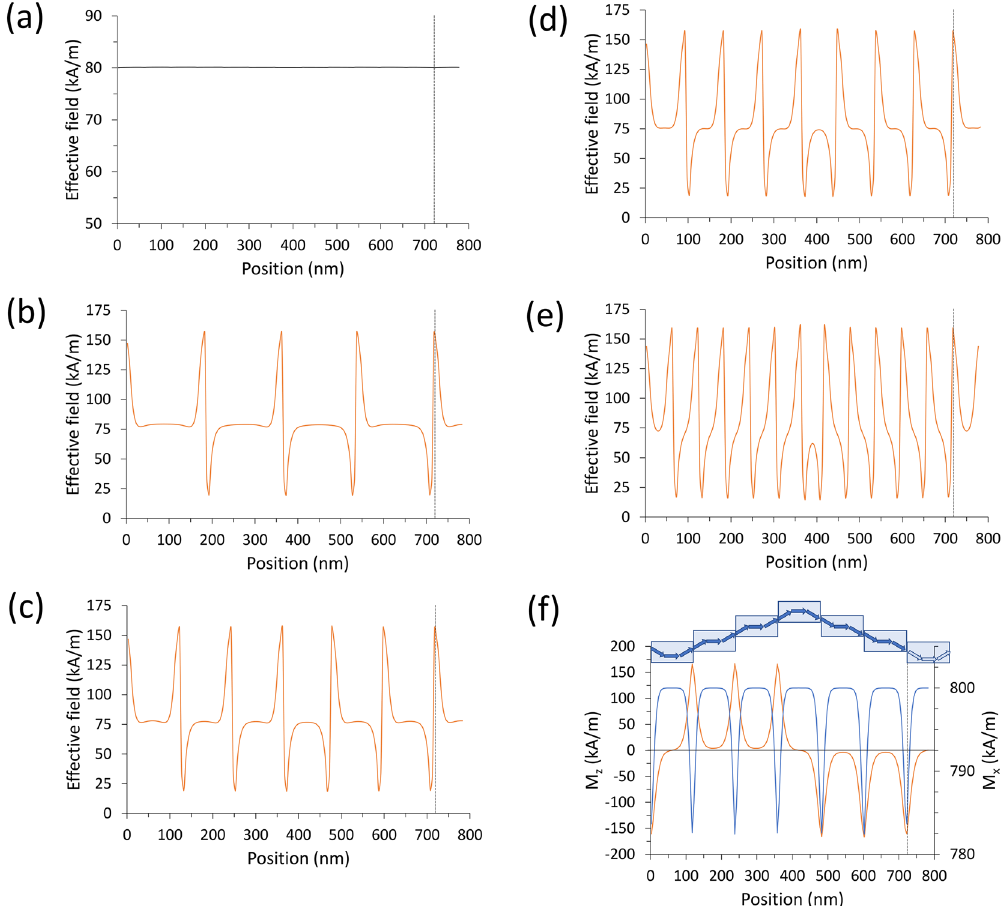
Figure 2. (a–e) Space profiles along the undulation direction of the internal effective field component parallel y ( x ) is uniform independently of the to the average magnetization direction: in (a), when M (cid:31) y , the profile H eff undulation amplitude (from the planar film to the 12-stripe system); despite the many geometric discontinuities, y ( x ) is uniform (computational confidence within 0.05 due to the different heights of the adjacent stripes, H eff kA/m) independently of the applied field magnitude. In (b–e) , when M (cid:31) x , instead, H x eff ( x ) is highly non- uniform: (b) 4-stripe system; (c) 6-stripe system; (d) 8-stripe system; (e) 12-stripe system. In (f) we plot both magnetization components M z ( x ) (orange curve, left axis) and M x ( x ) (blue curve, right axis) of the top layer in the (representative) 6-stripe system, when M (cid:31) x ; a sketch of the magnetization along the primitive cell is juxtaposed, illustrating the behavior of its out-of-plane component across the vertical sections of the 6